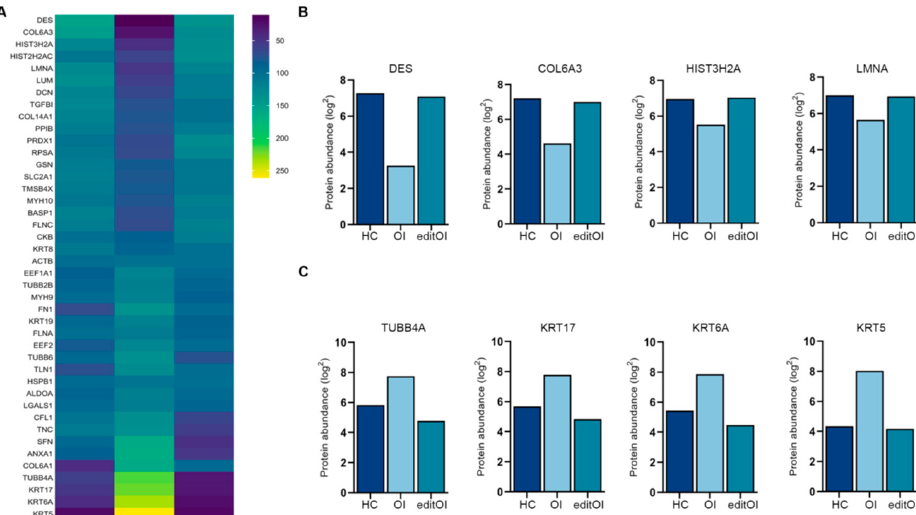
Figure 5. Label-free quantitative analysis of OI-OBs and editOI-OBs. ( A ) Hierarchical clustering of the differentially expressed proteins. Yellow denotes high relative expression, and blue denotes low relative expression. ( B , C ) Four proteins with high Score Sequest HT in HC and editOI-OBs and four proteins with high Score Sequest HT in OI-OBs were identified.